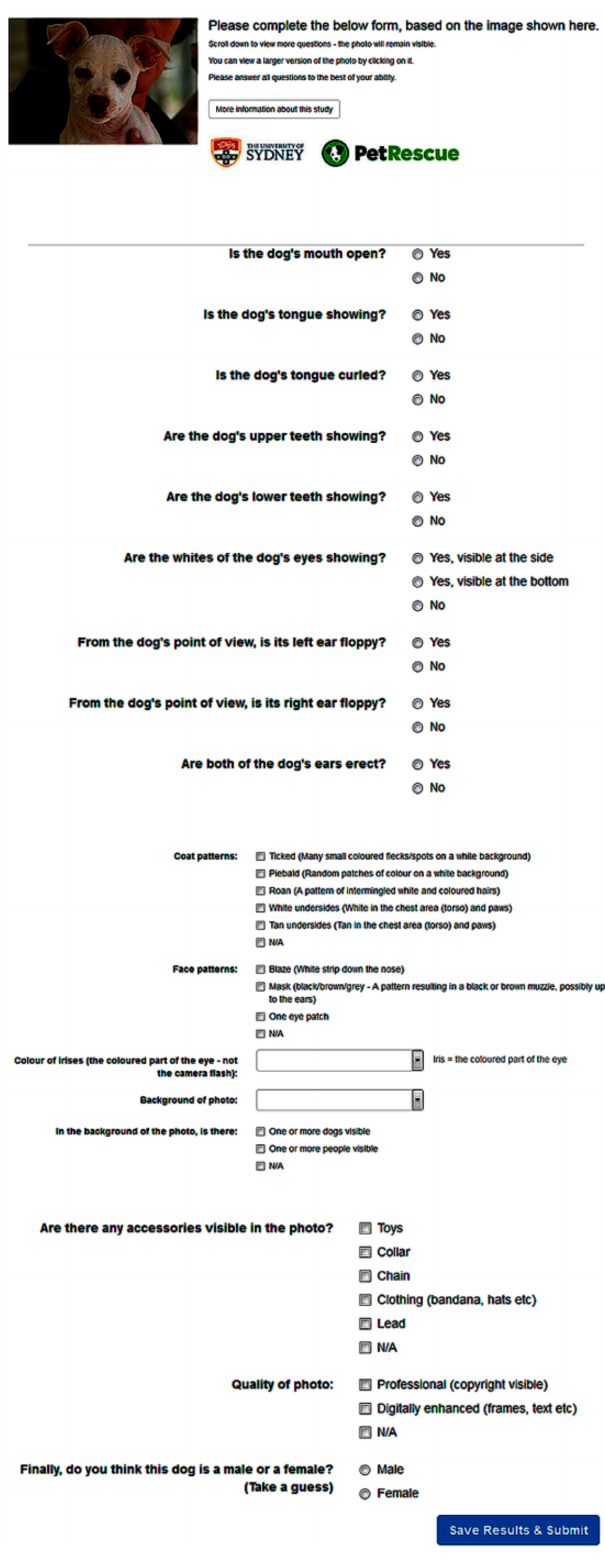
Figure 1. Screen shot of web form posted online on the PetRescue social media for online selection of data about photographs of dogs (http: // thinklateral.com.au / dog /